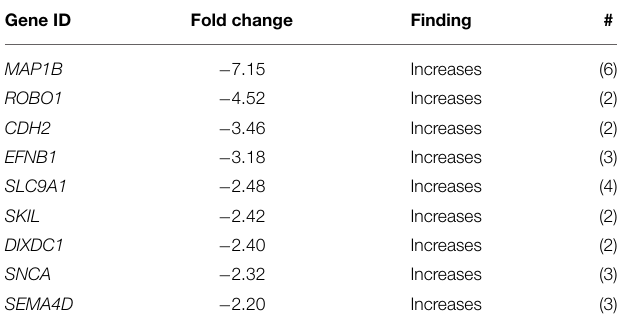
TABLE 4B | The 20 most regulated genes predicting a decrease in Vasculogenesis between GD90 and GD165.